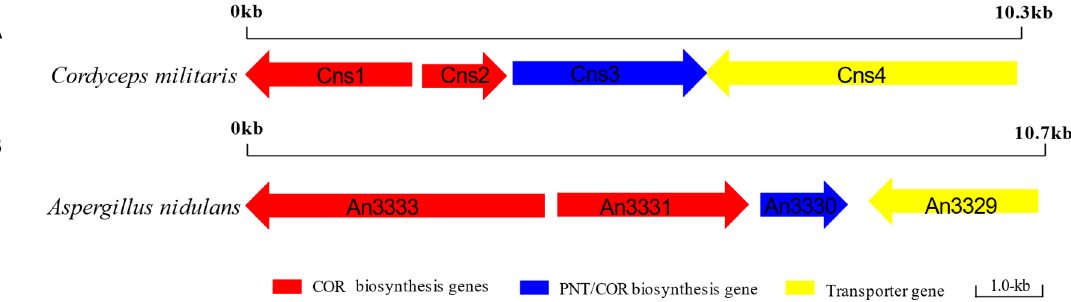
Table 4. The proposed functions of proteins in the biosynthesis gene cluster of PNT and COR in the Cordyceps militaris .